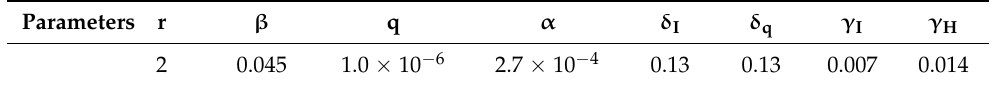
Table 1. Parameters in modified SEIR model.